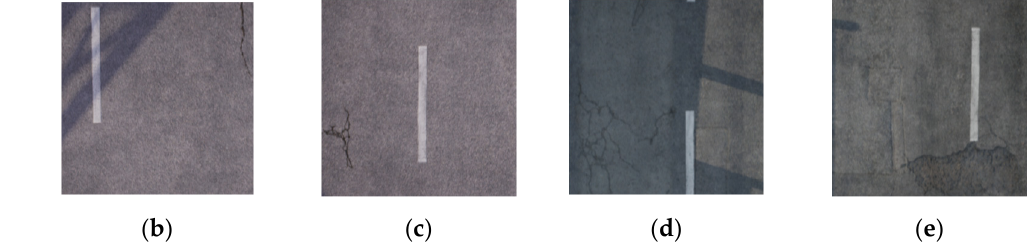
Figure 4. Schematic diagram of 5 types of virtual pavement distress. ( a ) Transverse crack. ( b ) Longitudinal crack. ( c ) Cross crack. ( d ) Alligator crack. ( e ) Pothole.